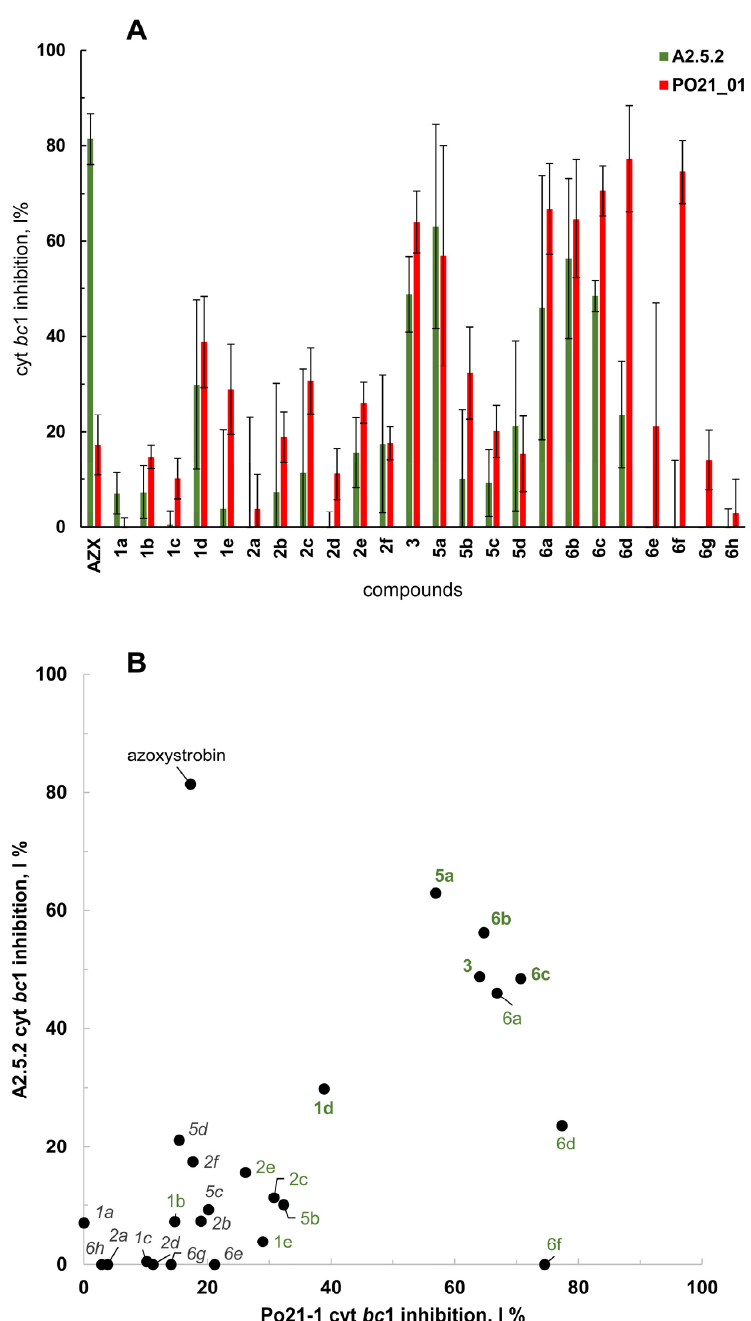
Figure 2. Enzymatic inhibition of cytochrome bc1 by the compounds. ( A ) NADH:cyt c oxidoreductase activity of the mitochondrial fractions from strobilurin-sensitive A2.5.2 (green bars) and -resistant PO21_01 (red bars) strains was assayed in the presence of compounds. Enzyme inhibition is reported as a percentage (I%) of the control activity where the tested compound is replaced by DMSO, the diluent used for compound stocks. AZX, azoxystrobin. Error bars represent standard deviation of the mean. ( B ) Graphical representation of the inhibitory action of compounds on the mitochondrial cyt bc1 enzyme function of the strobilurin-sensitive A2.5.2 and -resistant PO21_01 strains. In italics, no statistically relevant inhibition for both strains ( p > 0.01); in green, statistically relevant inhibition for the strobilurin-resistant strain ( p < 0.01); in boldfaced green, statistically relevant inhibition for both strains ( p < 0.01); in regular typing, statistically relevant inhibition for strobilurin-sensitive strain ( p <